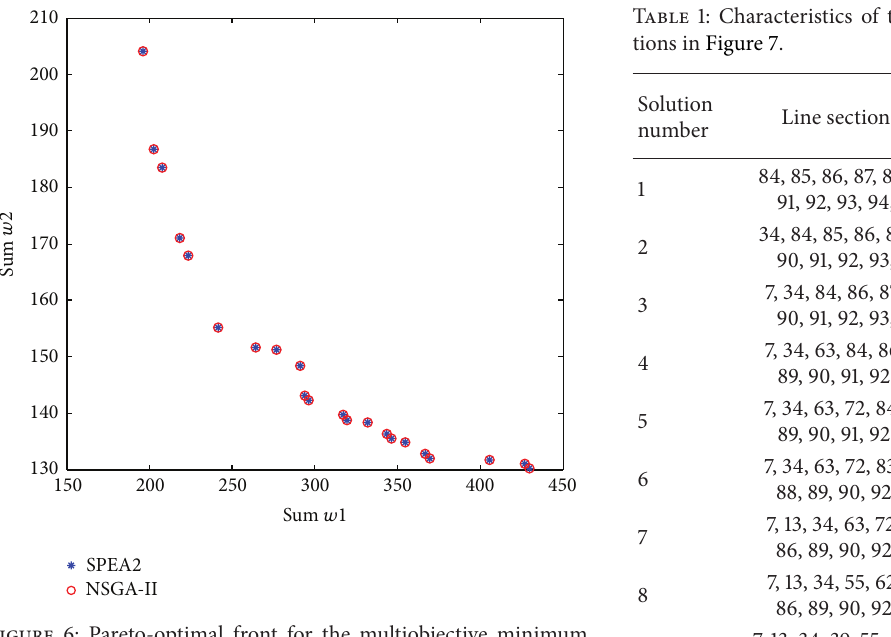
Figure 6: Pareto-optimal front for the multiobjective minimum spanning tree problem.